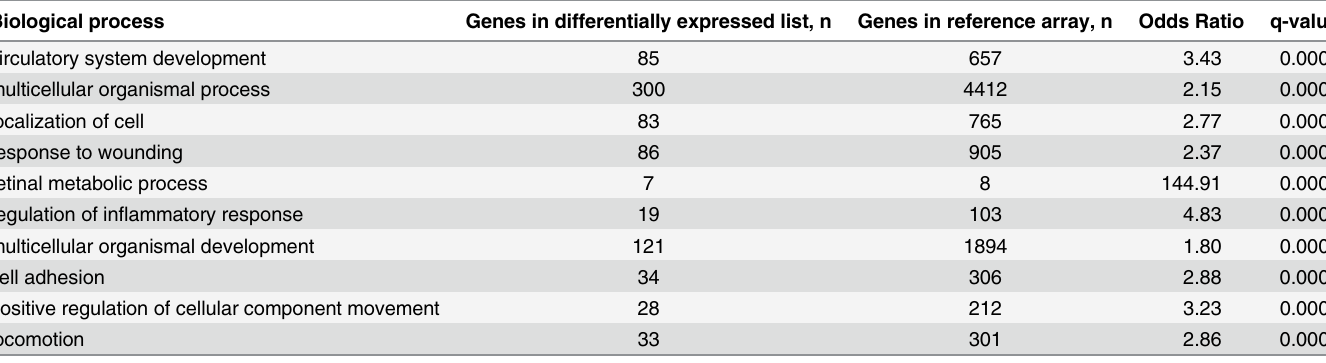
Table 3. A list of top 10 enriched biological processes in the comparison between visceral and subcutaneous adipose tissues of pregnant women. Biological process